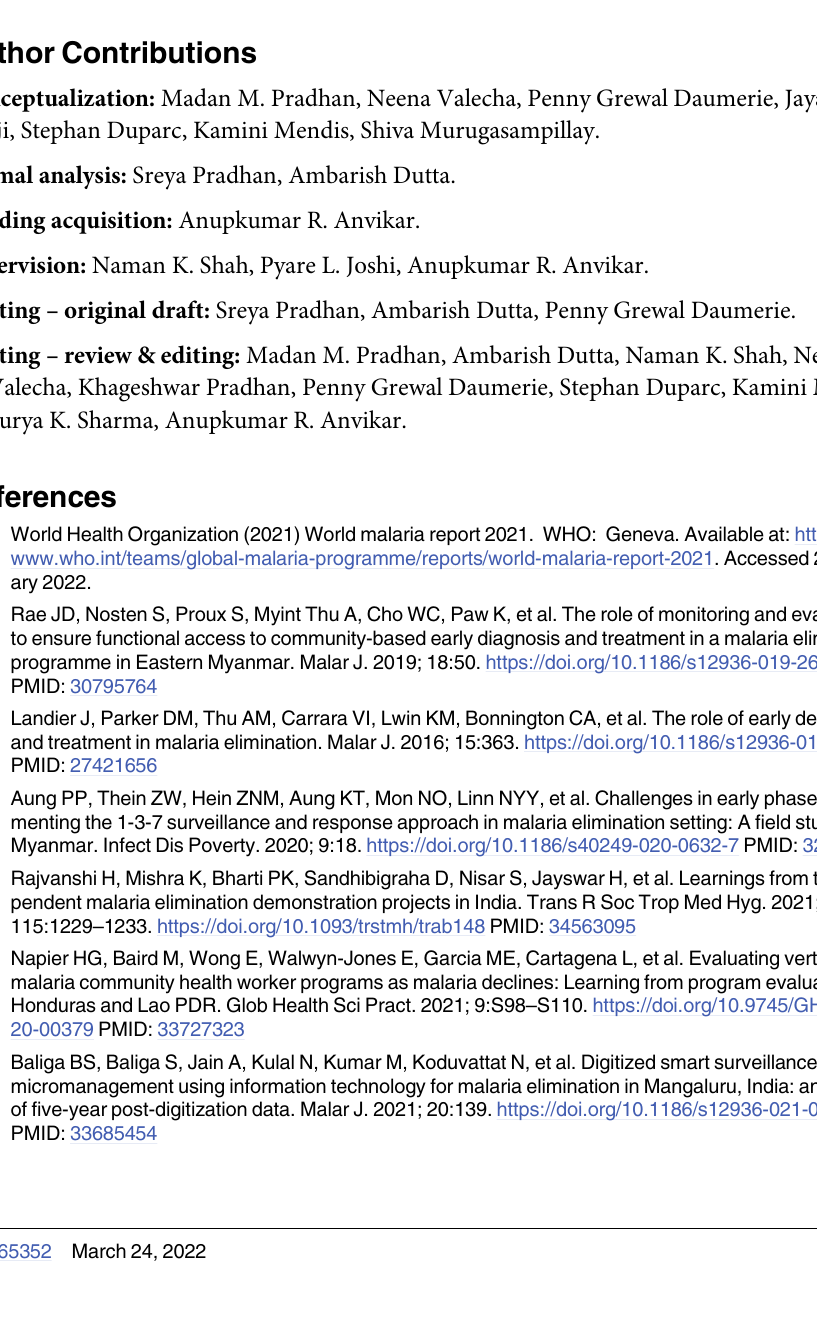
S7 Table. Interrupted time-series analysis of trends and levels for monthly parasite